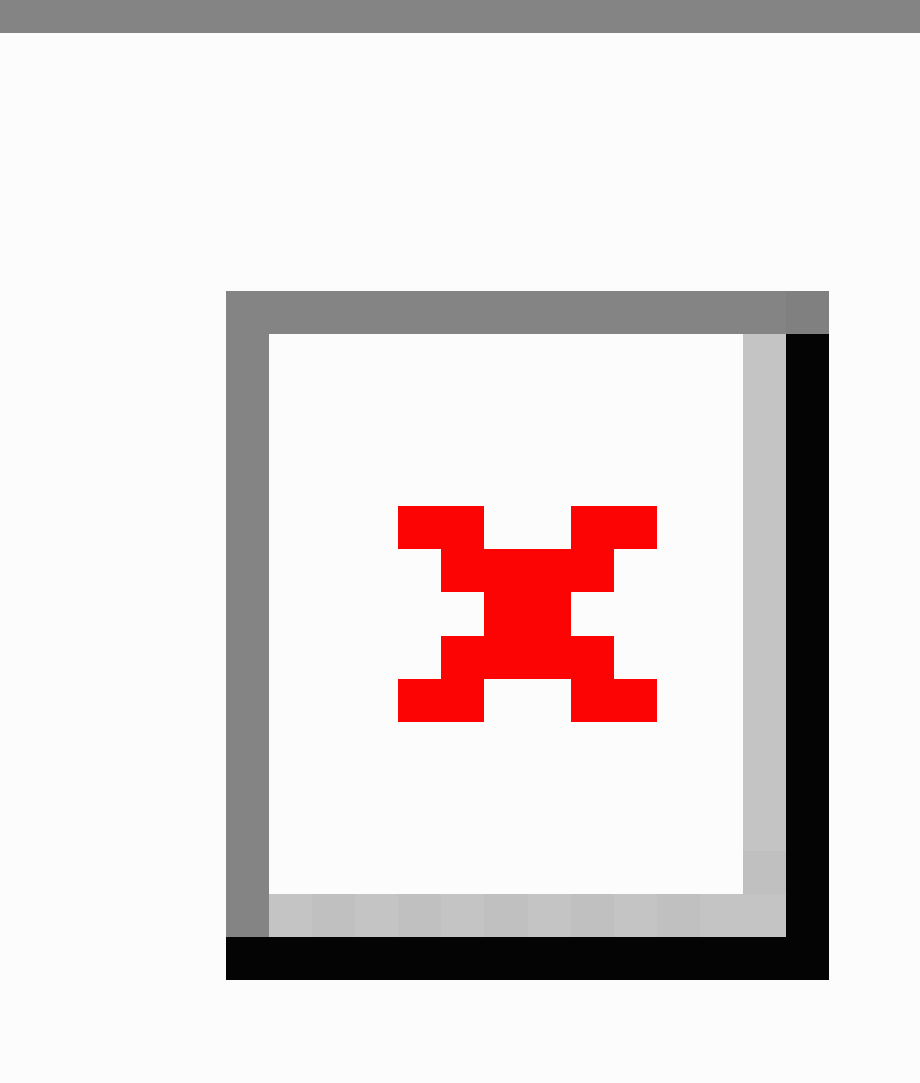
Figure 3. Example of consolidated visual output using data collected from prepandemic and pandemic assessments